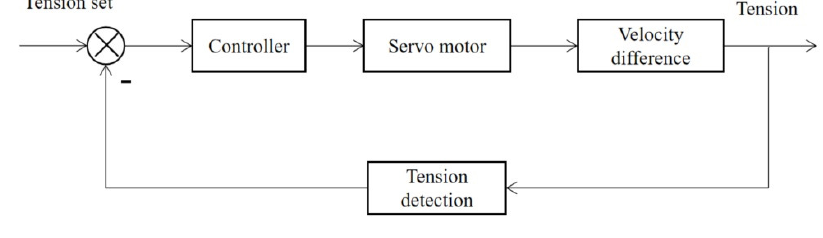
Figure 3. Principle block diagram of the tension control system.